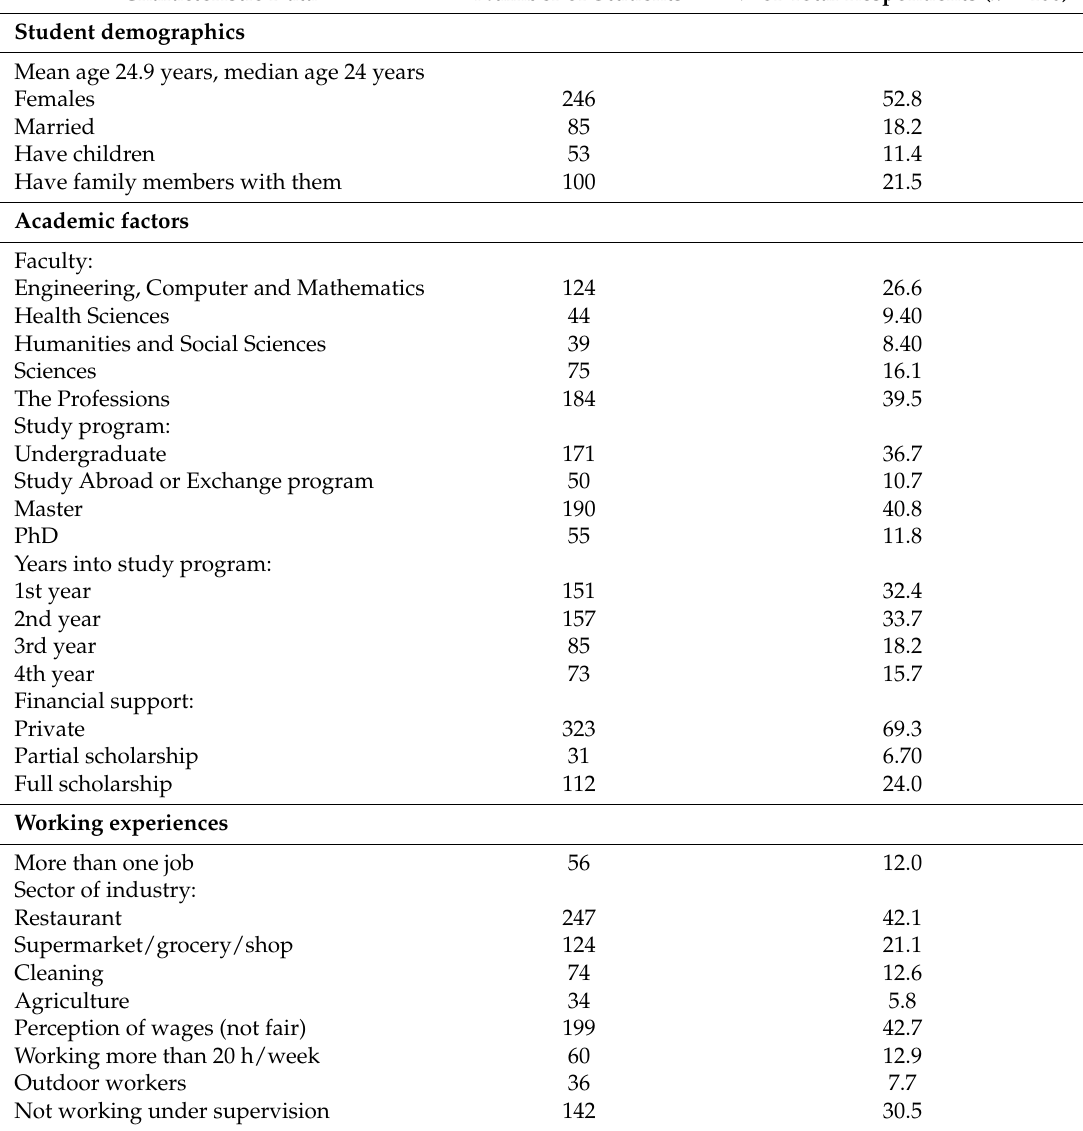
Table 1. International student worker characteristics and experiences. Characteristic